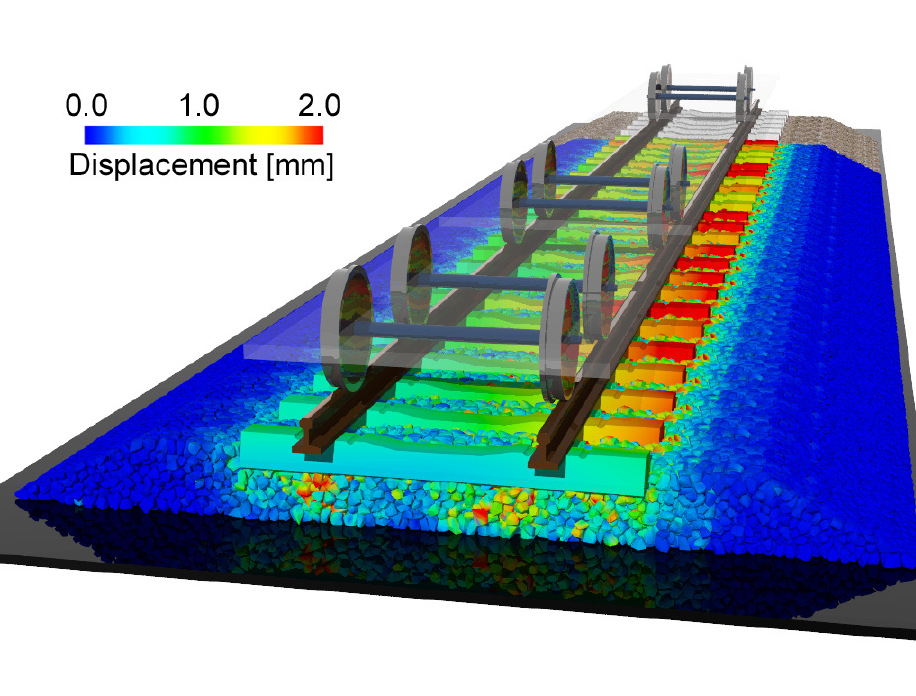
Figure 13. Snapshot of ballasted track dynamics simulation for a large-scale model of 24 sleepers using eight GPUs. The displacement is shown with a magnification of 20 × . A video sequence of this simulation can be found as the Supplementary Material in Video S2.